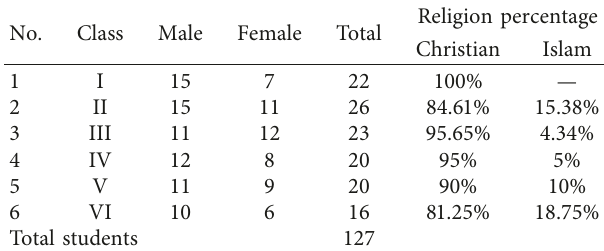
Table 2: Percentage of total students at Suwaan State Elementary School, North Minahasa, 2020/2021.